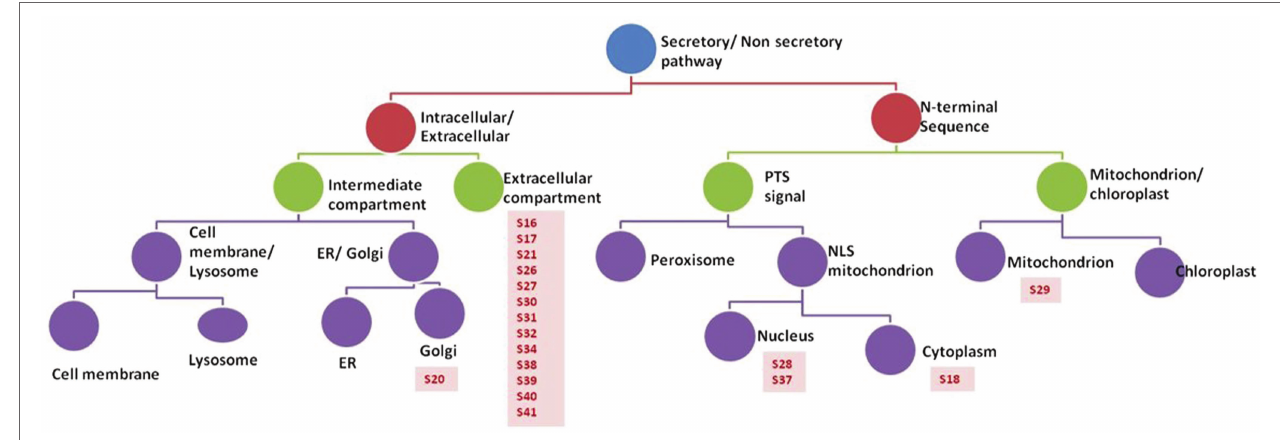
FIGURE 4 | Analysis of peptides secreted by R. arrhizus var. delemar . Prediction analysis of the sub-cellular localization of the R. arrhizus var. delemar small peptides was carried out using DeepLoc1.0 (Almagro Armenteros et al., 2017; http://www.cbs.dtu.dk/services/DeepLoc/instructions.php).